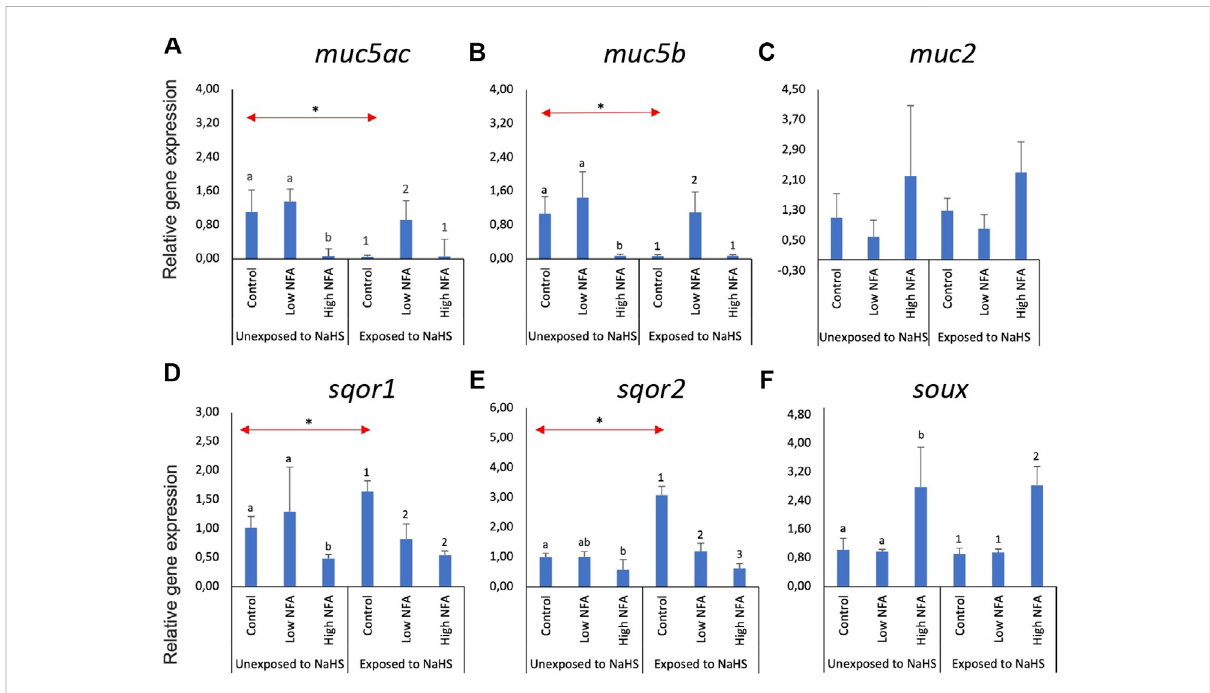
FIGURE 3 Relative gene expression of mucin genes (A – C) and sulphide-detoxi fi cation genes (D – F) in olfactory rosette explants treated with the mucus inhibitor Ni fl umic acid (NFA) with and without NaHS exposure. Statistically signi fi cant differences ( p -value < 0.05) within samples not exposed to NaHS are denoted by letters while numeric marks denote the differences within those exposed to NaHS. Red arrows indicate signi fi cant differences across NaHS exposure ( p -value < 0.05). Please note the differences in the y